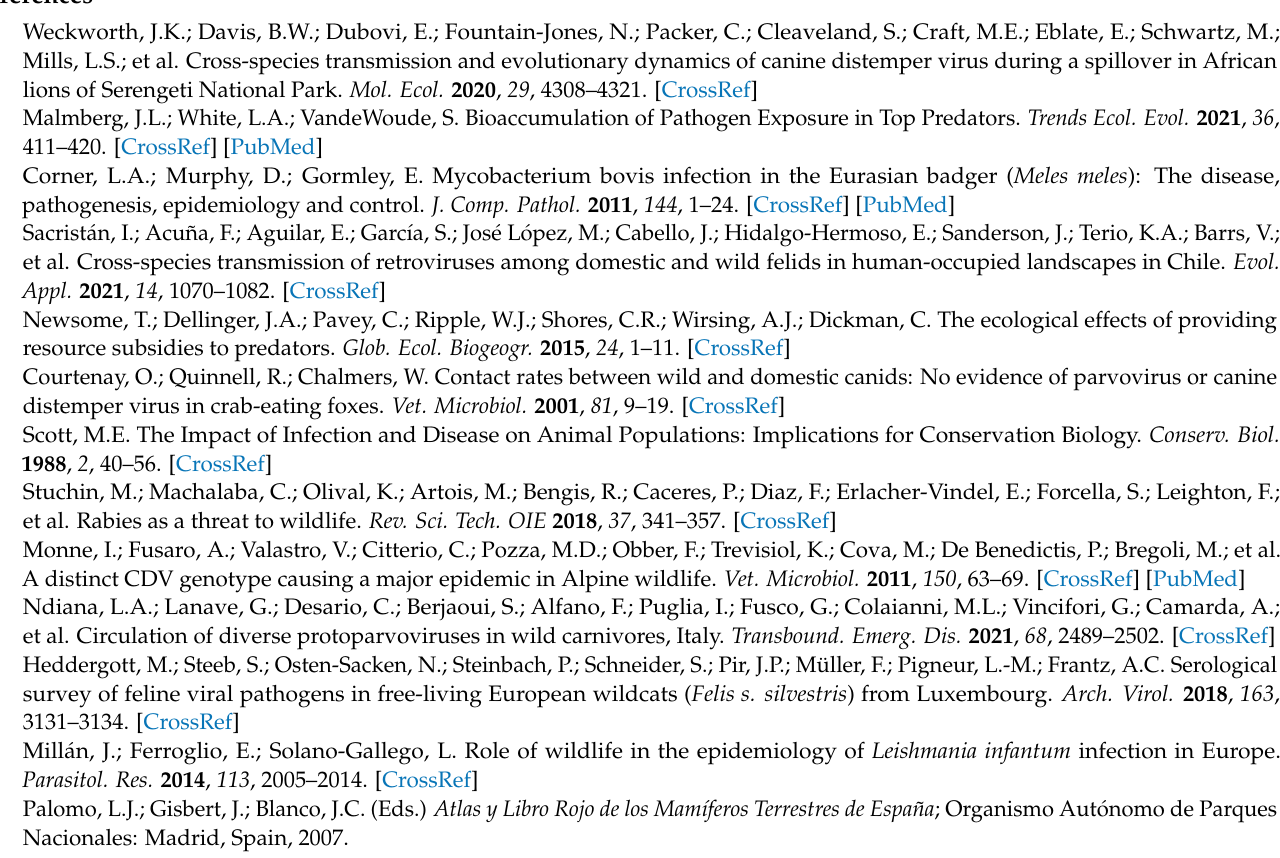
Table S6. Predicted seroprevalence from our meta-analysis model. Table S7. Results of phylogenetic factorization applied to each primary response variable. Table S8. Test statistics from phylogenetic meta-analysis models applied to infection prevalence and seroprevalence data. Table S9. Predicted infection prevalence from our meta-analysis models for each broad pathogen taxon. Table S10. Pre- dicted seroprevalence from our meta-analysis models for each broad pathogen taxon. Table S11. Test statistics from phylogenetic meta-analysis models applied to exposure for the three focal pathogens. Table S12. Results of phylogenetic factorization applied to prevalence or seroprevalence for each main pathogen taxon. Table S13. Results of phylogenetic factorization applied to prevalence or seroprevalence for the three most common pathogens in Iberian carnivores. Table S14. Results from the negative binomial GAM predicting pathogen sharing. Table S15. Post-hoc comparisons from the negative binomial GAMM of pathogen